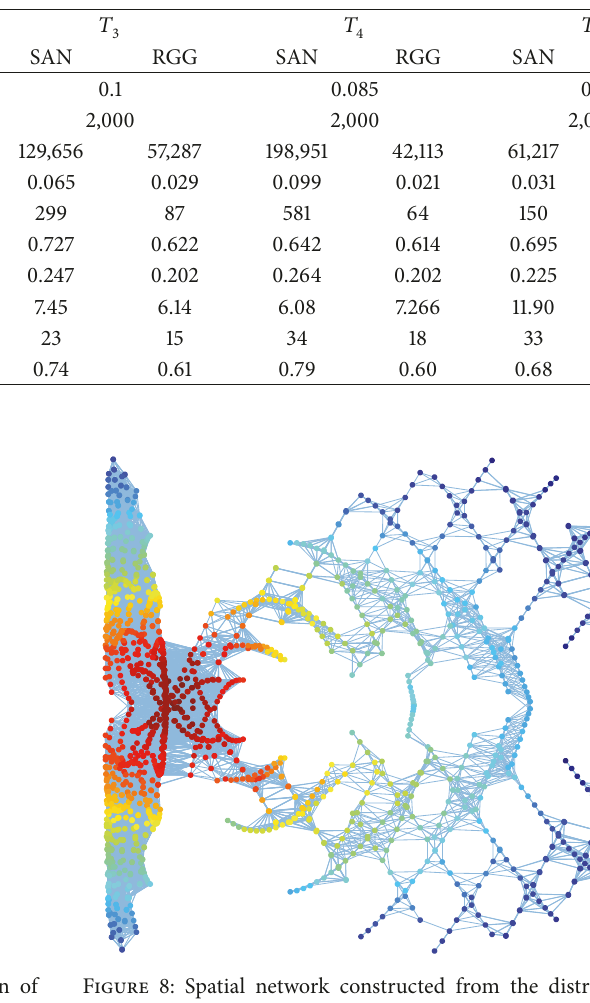
Table 1: Graph-theoretic invariants of the spatial “artistic” networks described in Section 4.